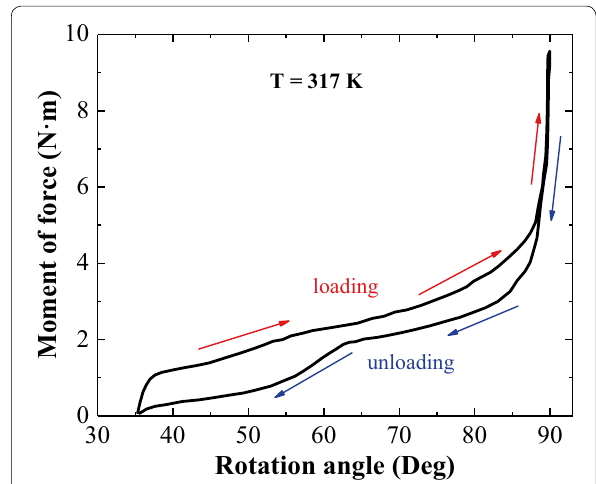
Figure 5 Curve of the moment of force versus the rotation angle of punch head at 317 K